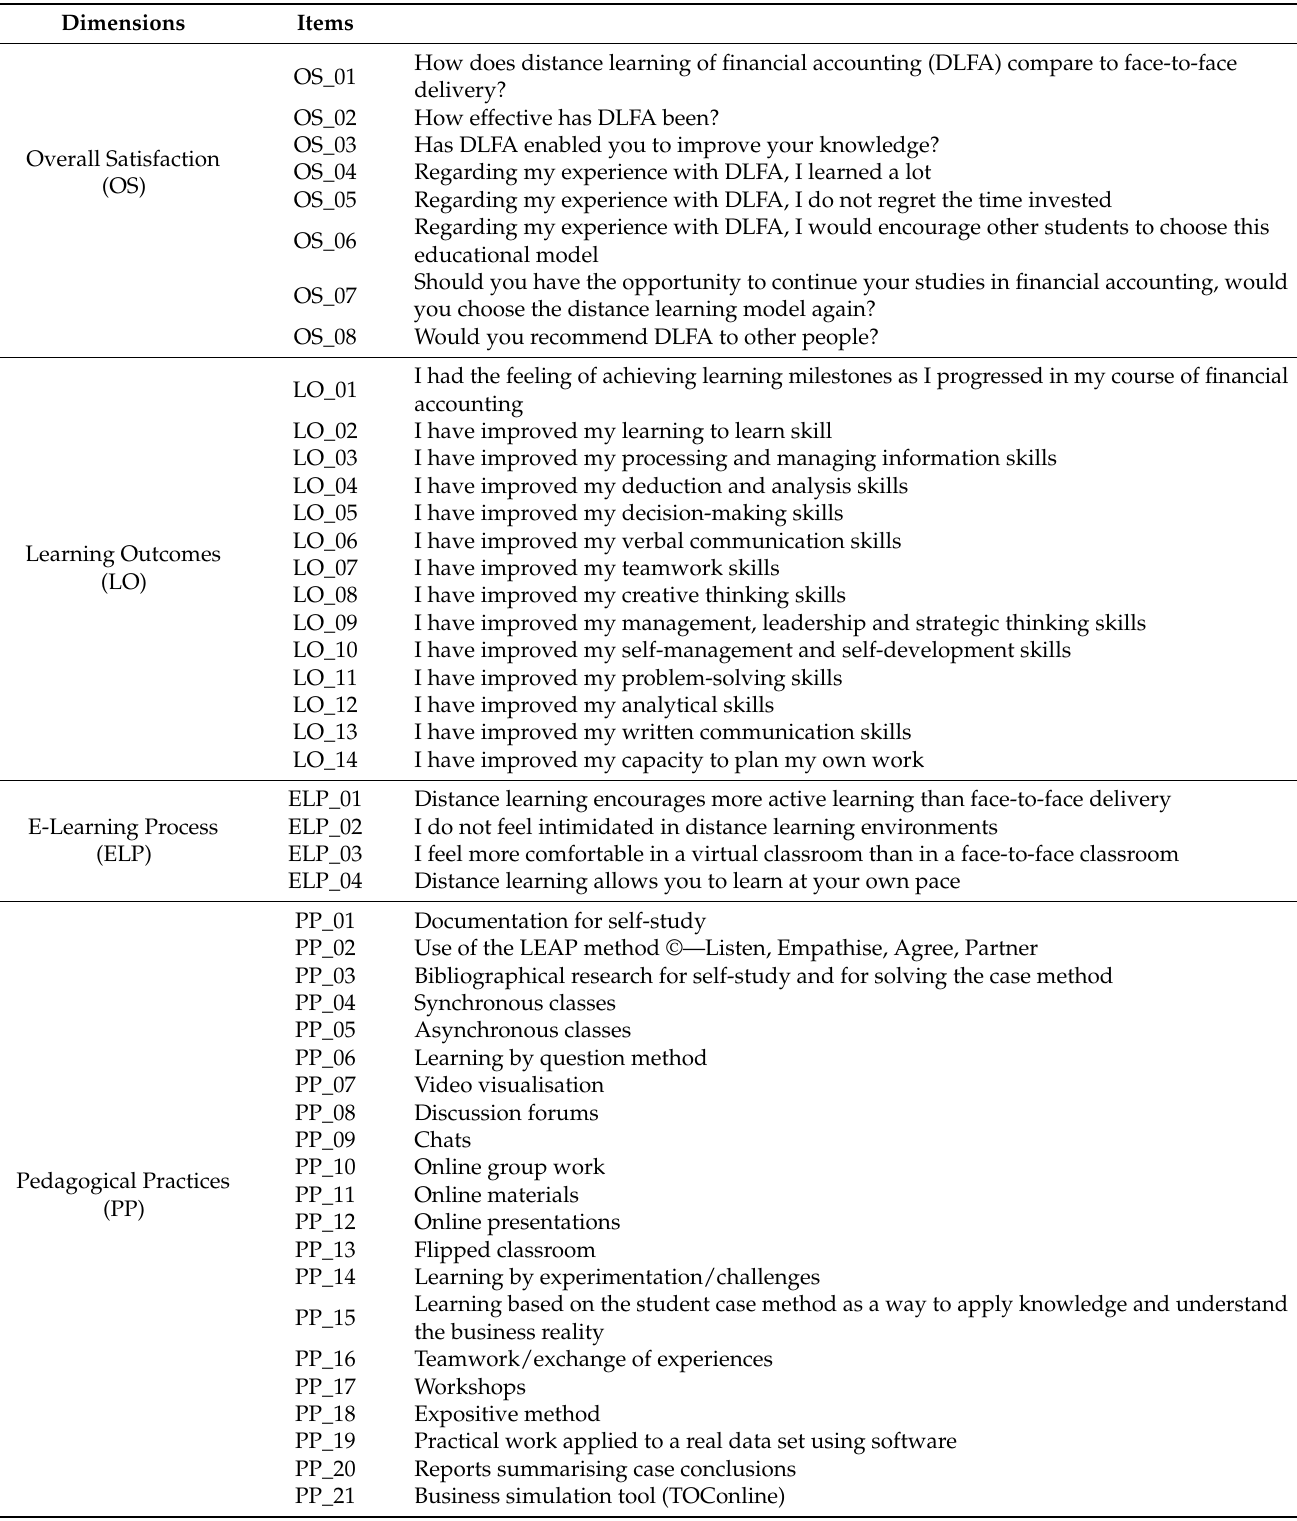
Table 6. List of items integrated in each of the four research